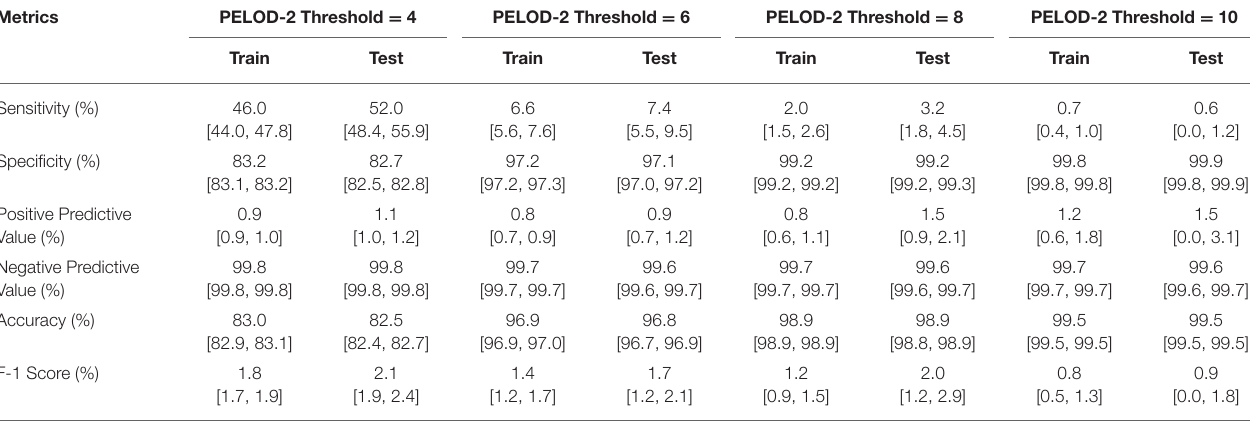
TABLE 3 | Performance of PELOD-2 score in predicting PSI * in the next 48h of hospitalization. Metrics PELOD-2 Threshold = 4 PELOD-2 Threshold = 6 PELOD-2 Threshold = 8 PELOD-2 Threshold = 10 Train Test Train Test Train Test Train